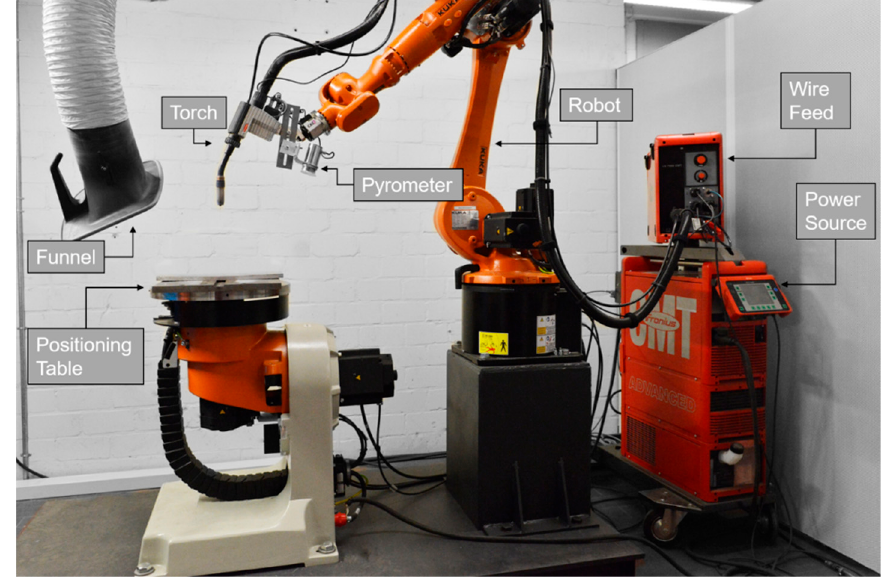
Figure 2. Experimental setup for the WAAM of steel bars [34].